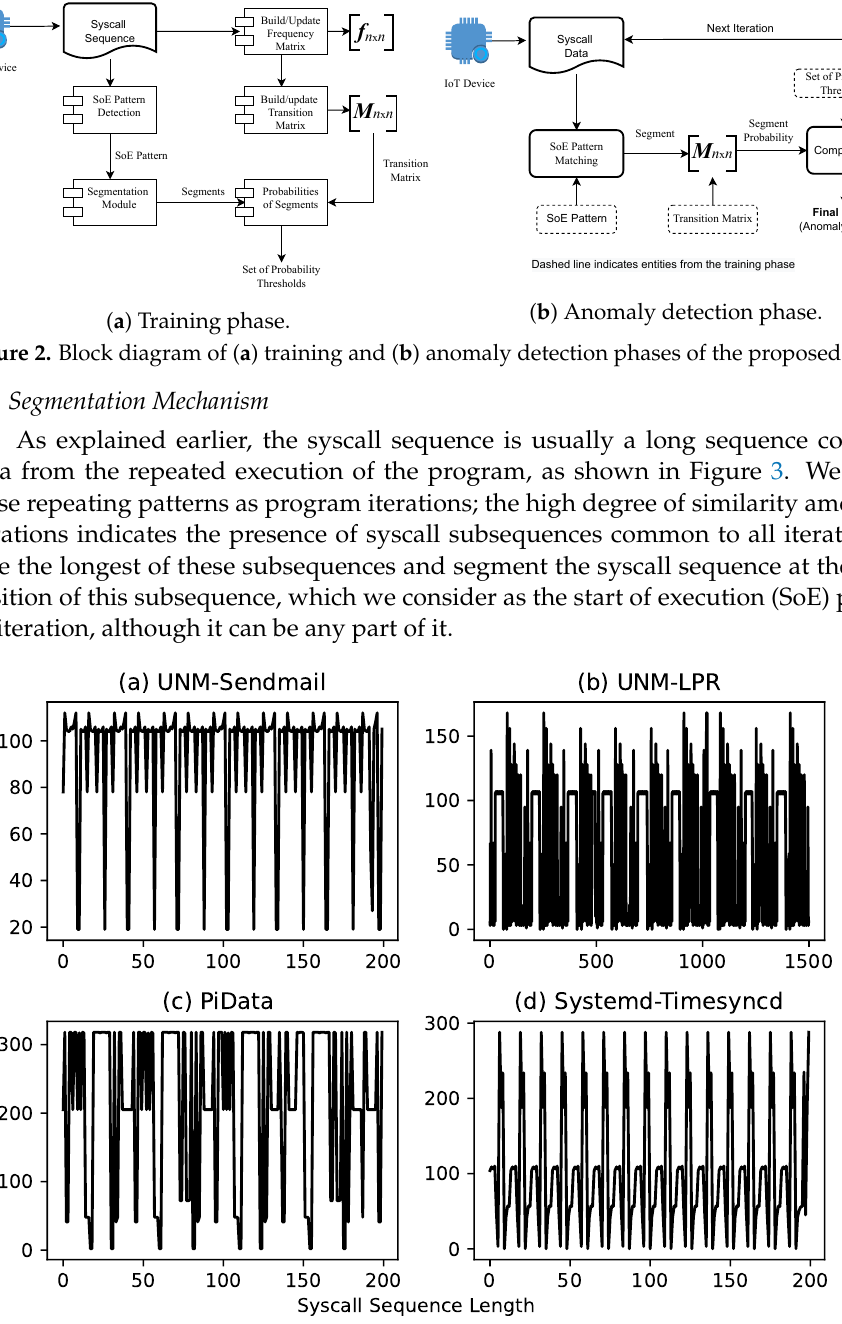
Figure 3. Line plot of syscall sequences taken from three datasets ( a – c ) and a standard Linux process ( d ). Each syscall sequence exhibits a repeated pattern of varying length, for example, the UNM Sendmail plot shows that the syscall pattern is repeated after 15 calls, whereas in the UNM-LPR plot, the syscall pattern is repeated after approximately 166